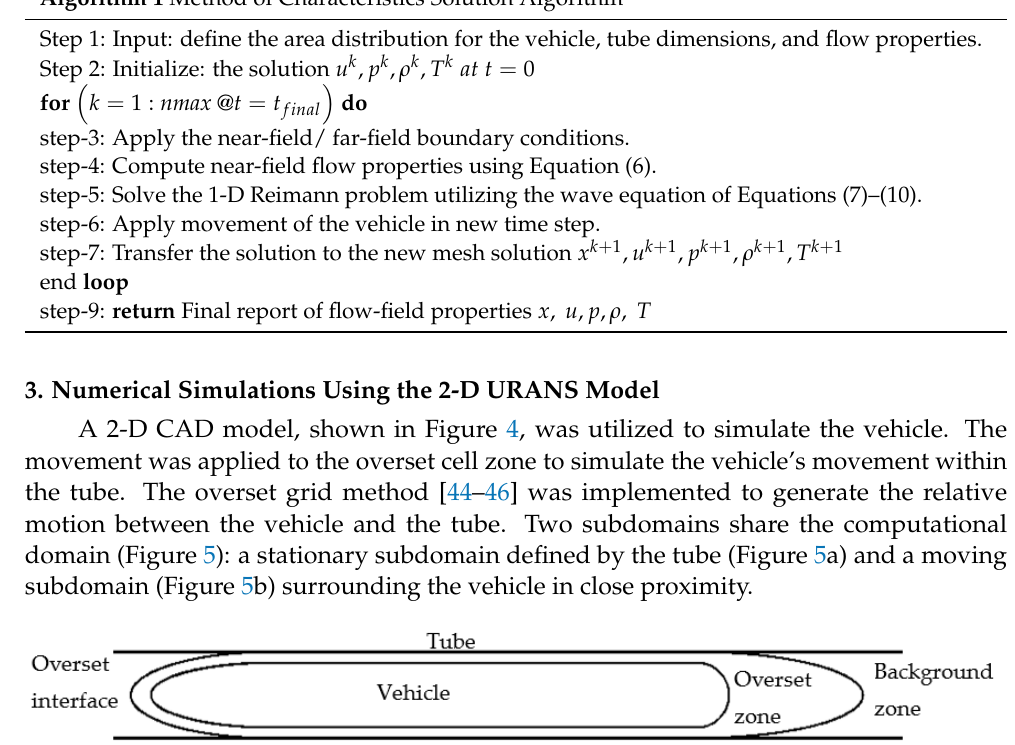
Figure 4. Overset boundary zone and interface.